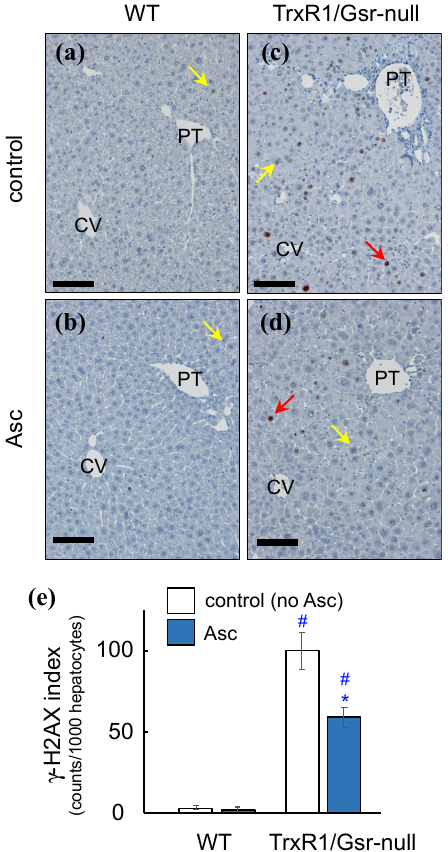
Figure 6. Impact of ascorbate treatment on basal levels of DNA damage. Mice received 0 (control) ( a , c ) or 4 mg/g/day ascorbate × 4 days i.p. (Asc) ( b , d ) and were harvested 3 h after the final inoculation. n = 3–5 animals for each condition; representative data shown. Liver sections were immunostained for γ -H2AX. Red and yellow arrows indicate representative strong- or weak-staining hepatocyte nuclei, respectively, all of which would have contributed to positive counts in the γ - H2AX index. CV and PT, central veins or portal triads, respectively. Scale bars 100 μ m. Due to the previously reported genotype-specific cell size differences, photomicrographs at 200 × magnification showed ~420 or ~285 hepatocytes per field of view for WT and TrxR1/Gsr-null livers, respectively. ( e ) Quantification of γ -H2AX staining index. Bars mean ± s.e.m.; *, p ≤ 0.05 versus untreated no-ascorbate control of same genotype; #, p ≤ 0.05 versus WT under same treatment using